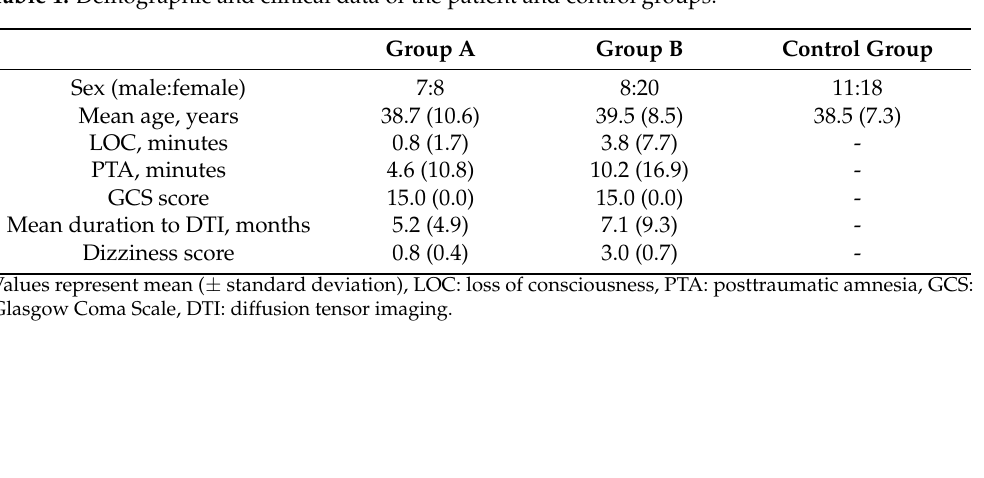
Table 1. Demographic and clinical data of the patient and control